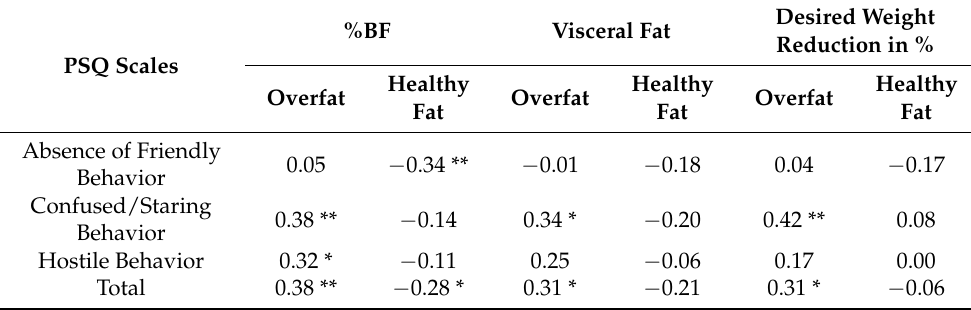
Table 2. Correlations of PSQ scales with %BF, visceral fat, and desired weight reduction (in